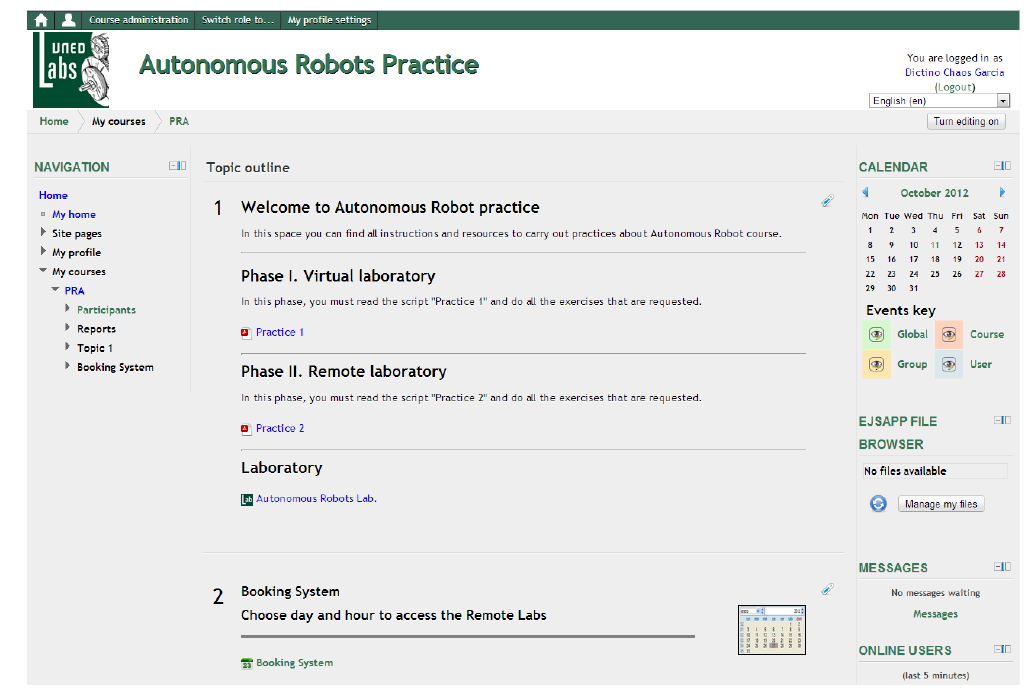
Figure 8. UNEDLabs Website and Autonomous Robots